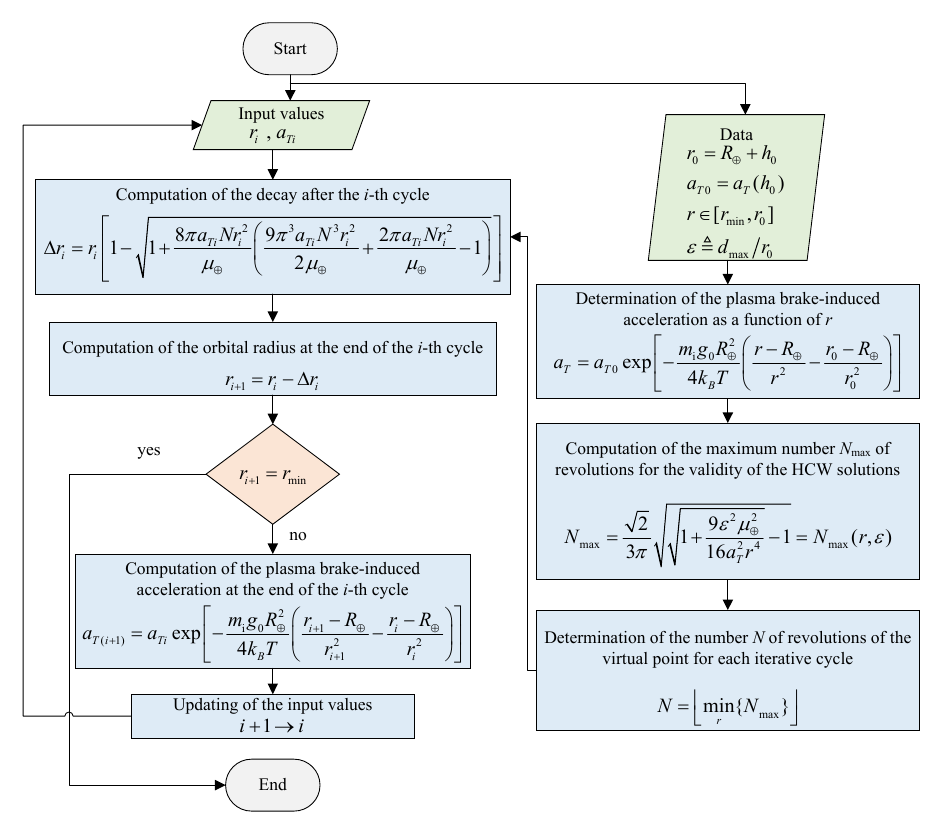
Figure 7. Flow chart of the algorithm for calculating the orbital decay.